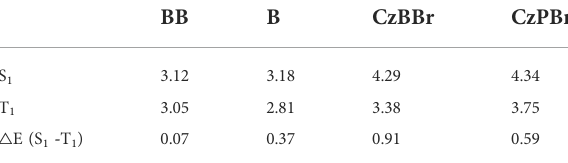
TABLE 1 The excited state energy (eV) and energy gap (eV) of the studied